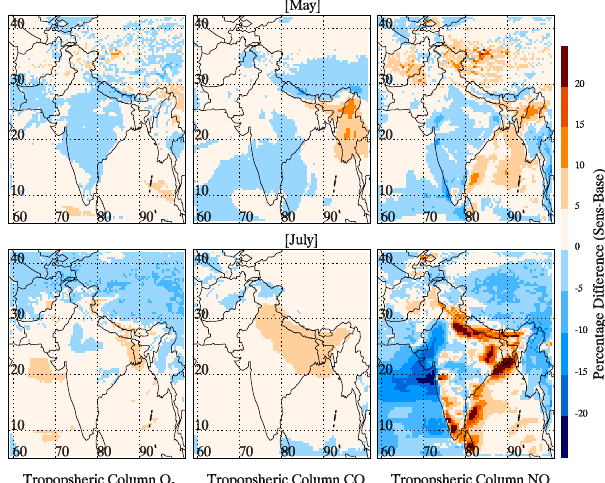
Fig. 14. Spatial distributions of percentage differences in model simulated tropospheric column ozone, CO and NO x between sensi- tivity and base model runs during May and July